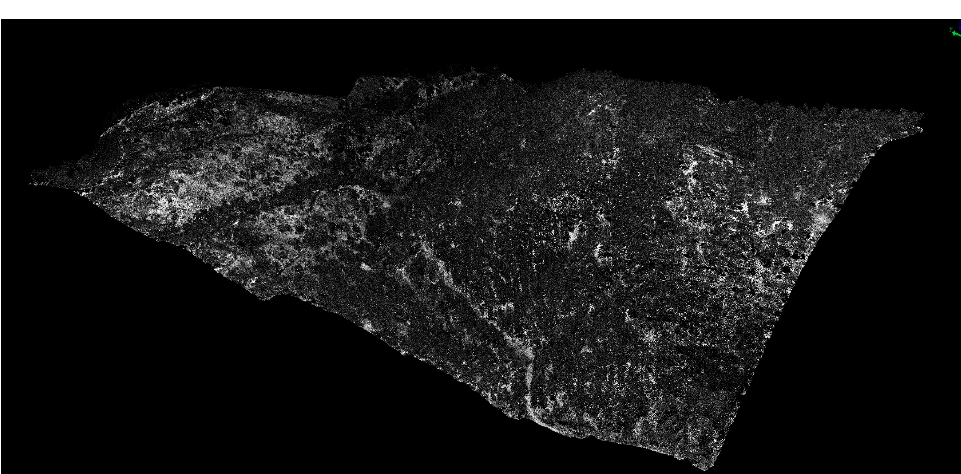
Figure S3. Soil sampling points. Figure A3. Soil sampling points.